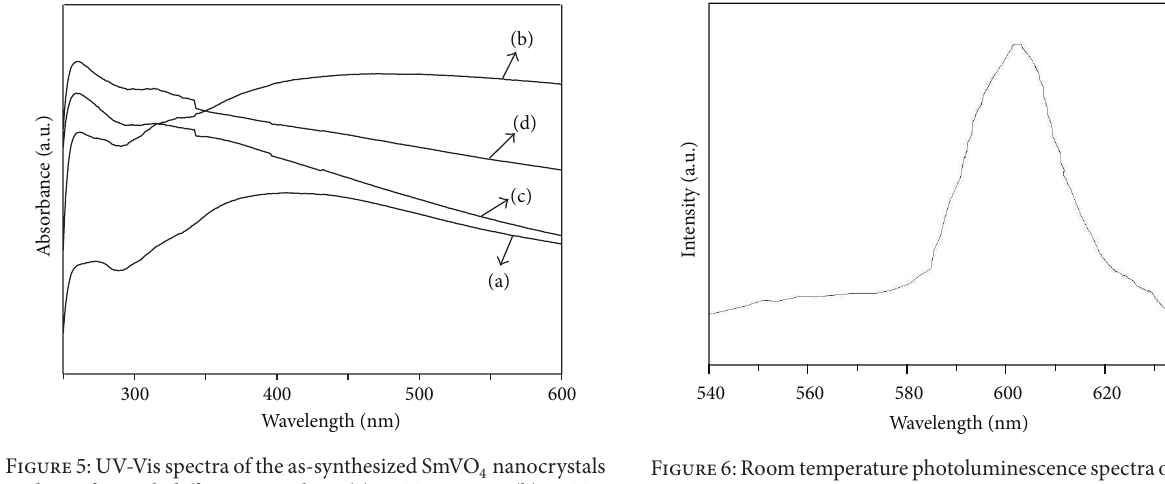
Figure6:Roomtemperaturephotoluminescencespectraoftetrago- nal SmVO 4 nanocrystals obtained after the hydrothermal treatment under 180 ∘ C, EDTA, pH =